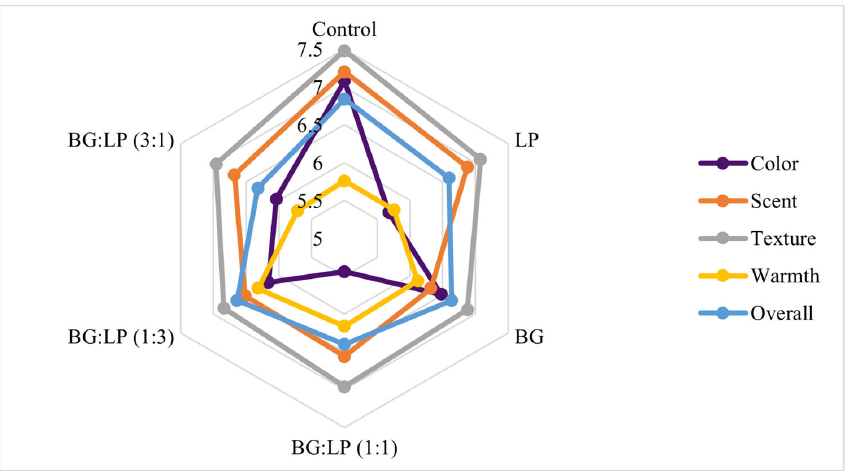
Figure 4. Spider graph of organoleptic results of spice stick balsams containing macroemulsions of lemon pepper (LP), black ginger (BG), and